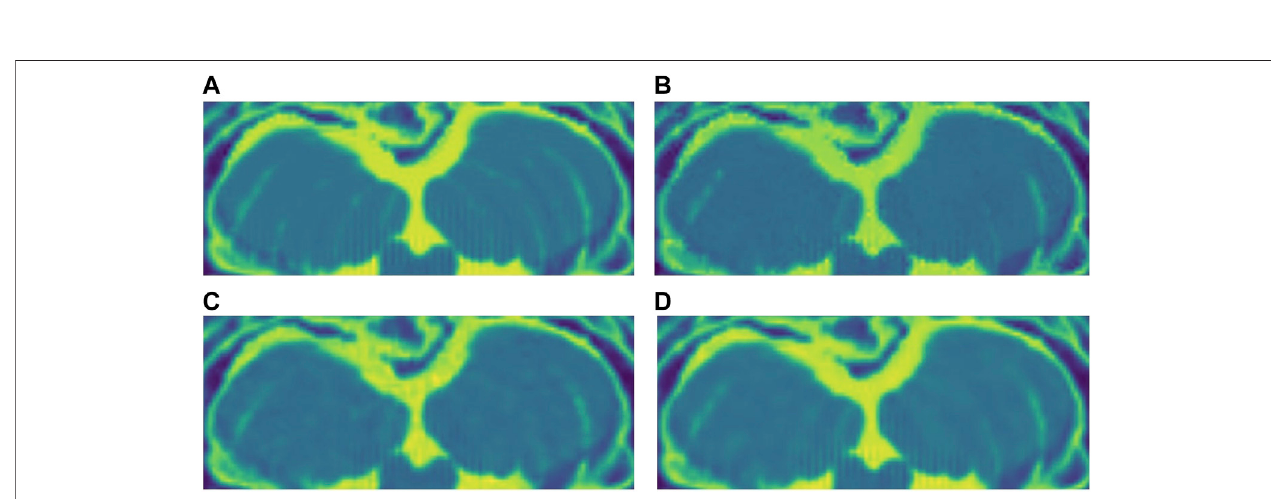
FIGURE10|(A) Originalclose-up.Nonoiseadded. (B) NLMdenoisedclose-up. (C) SUREnetworkdenoisedclose-up. (D) Blindspotdenoisedclose-up.Observe how all three algorithms do a good job at denoising, but NLM introduces undesired